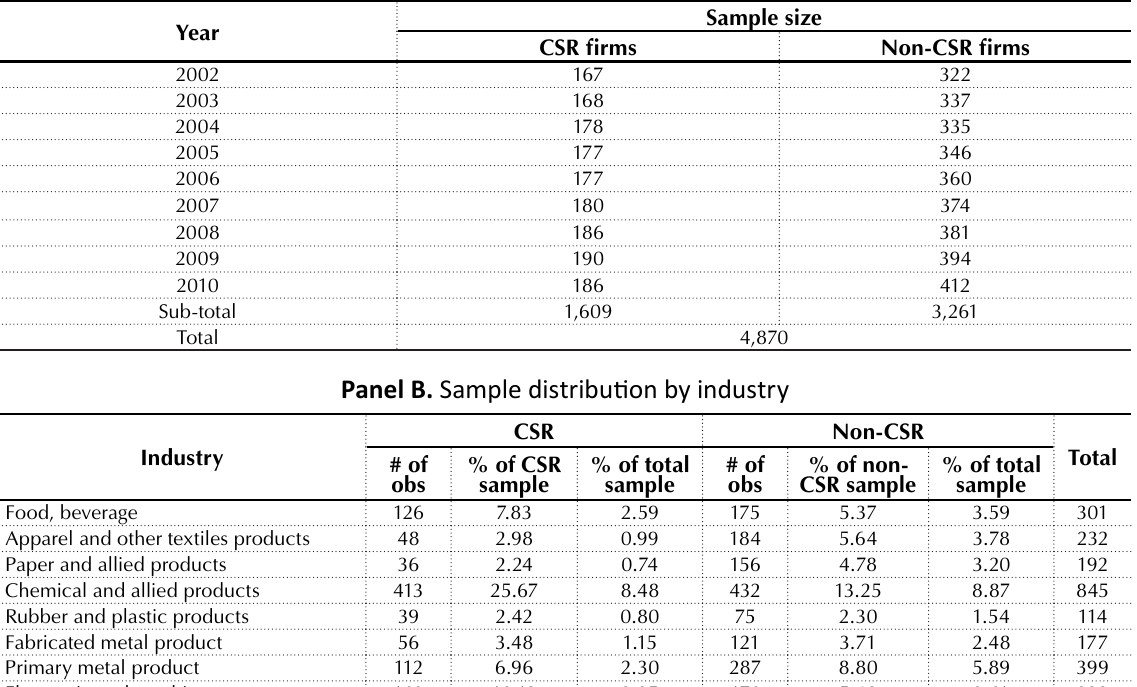
Table 1. Sample distribution